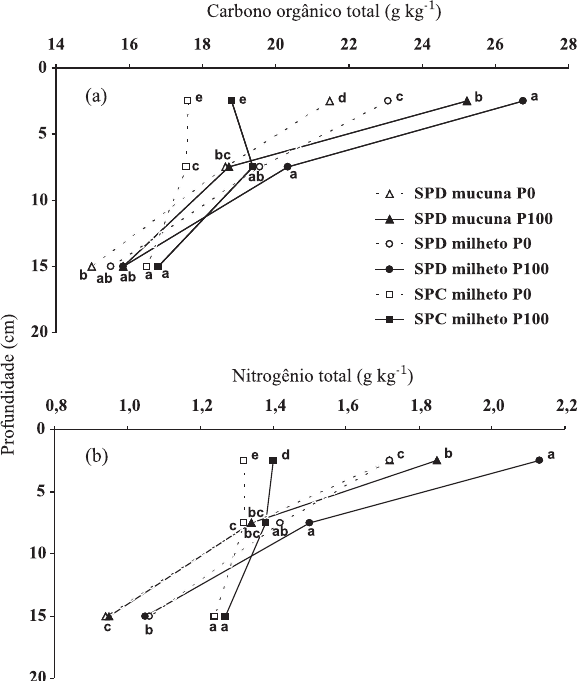
Figura 1. Distribuição de C orgânico total (a) e N